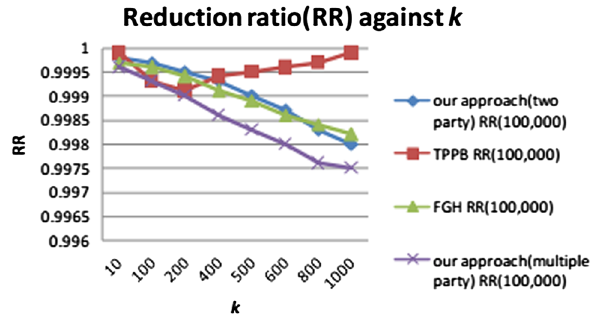
Fig. 5 RR with different values for k , dataset size =